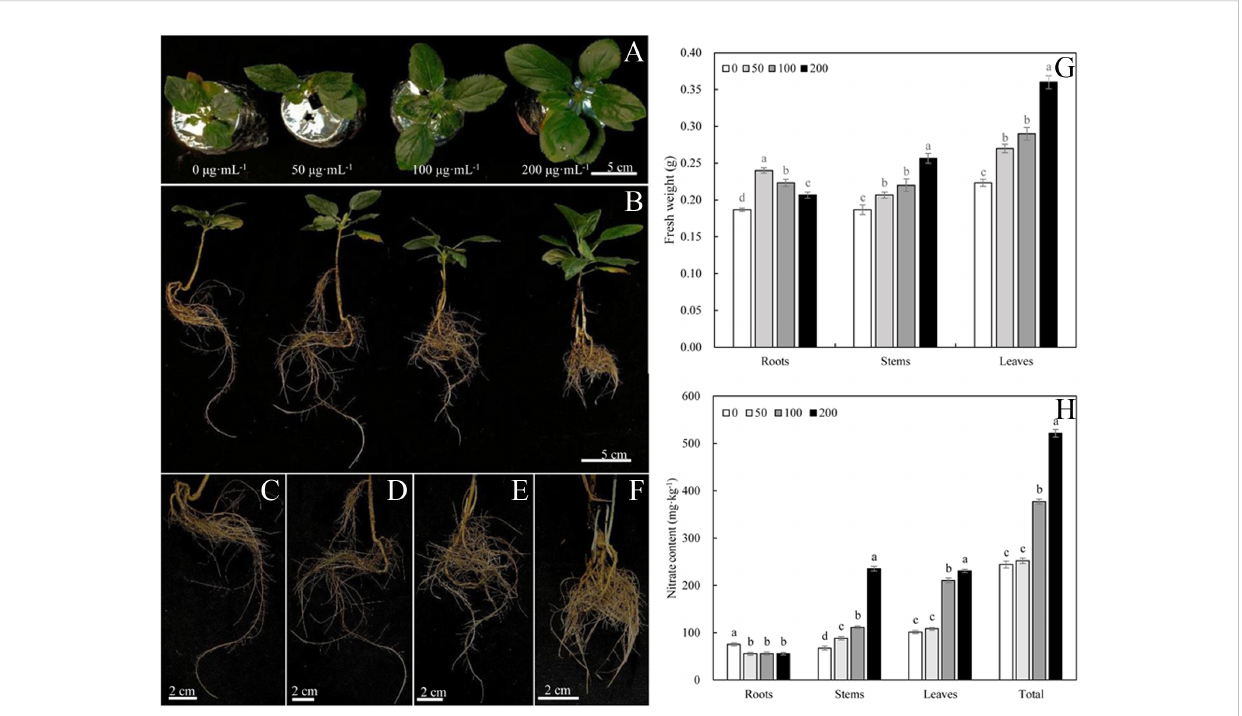
FIGURE 1 Phenotypes of leaves (A) , roots (C – F) , and whole plant (B) , fresh weights of roots, stems, and leaves (G) and nitrate content (H) of Malus hupehensis seedlings under the 0, 50, 100, and 200 µg·mL -1 MWCNTs treatments for 30 days. Different lowercase letters indicate signi fi cant difference at P < 0.05, and error bars represent the standard deviation of the mean (One-way ANOVA,